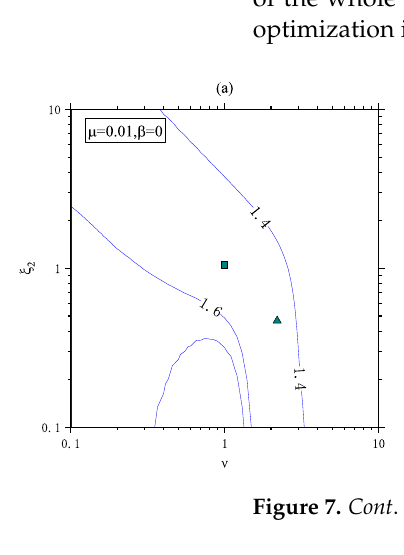
Figure 6. Main structure displacement variance σ 2 in the variation interval of parameters ν and ξ 2 . u 1 ( a ) β = 0 and ( b ) β = 0.09 and ( c ) β = 0.19 and ( d ) β = 0.49.